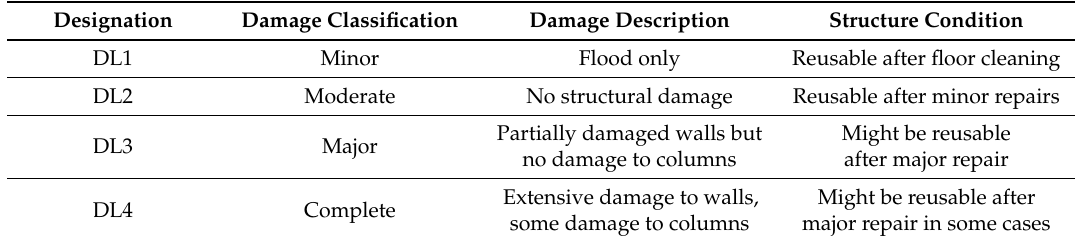
Table 4. Tsunami damage scale devised by the Ministry of Land, Infrastructure, Transport and Tourism (MLIT) in Japan.